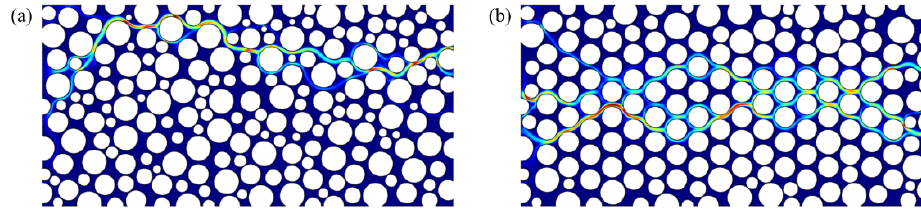
Figure 20. Under different absolute permeability conditions, cloud diagram of velocity field corre- sponding to injected 2 PV CO 2 . ( a ) K = 7.7192 × 10 − 11 m 2 ; ( b ) K = 1.5487 × 10 − 10 m 2 .